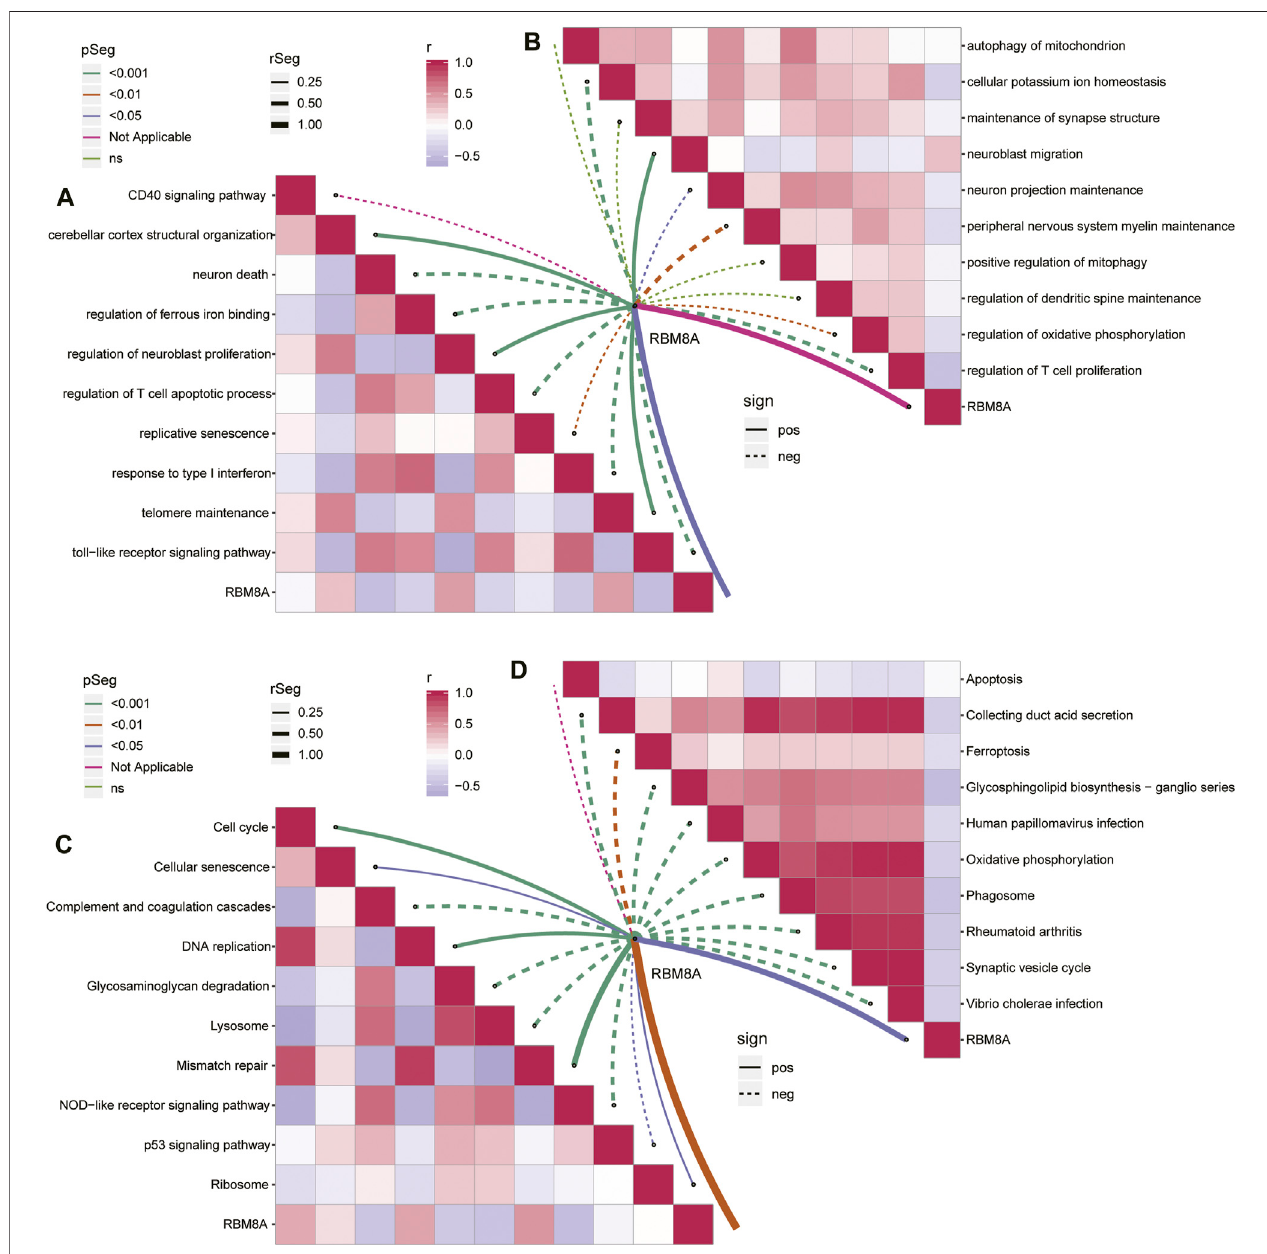
FIGURE 4 | Enrichment analysis of common mRNAs in GBM. (A,B) . Correlation between RBM8A and biological processes (A) activated or (B) inhibited by common mRNAs. (C,D) . Correlation between RBM8A and KEGG pathways (C) activated or (B) inhibited by common mRNAs.